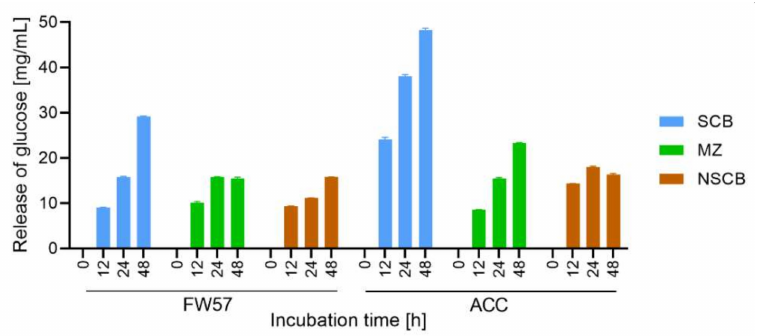
Figure 7. Glucose release by our in-house enzyme mixture and a commercial enzyme cocktail on steam-exploded sugarcane bagasse (XSCB), untreated (in nature) sugarcane bagasse (NSCB) and maize leaves (MZ). The enzymatic mixture was prepared from S. longicolleum (FW57), and the commercial cocktail was Accellerase 1500